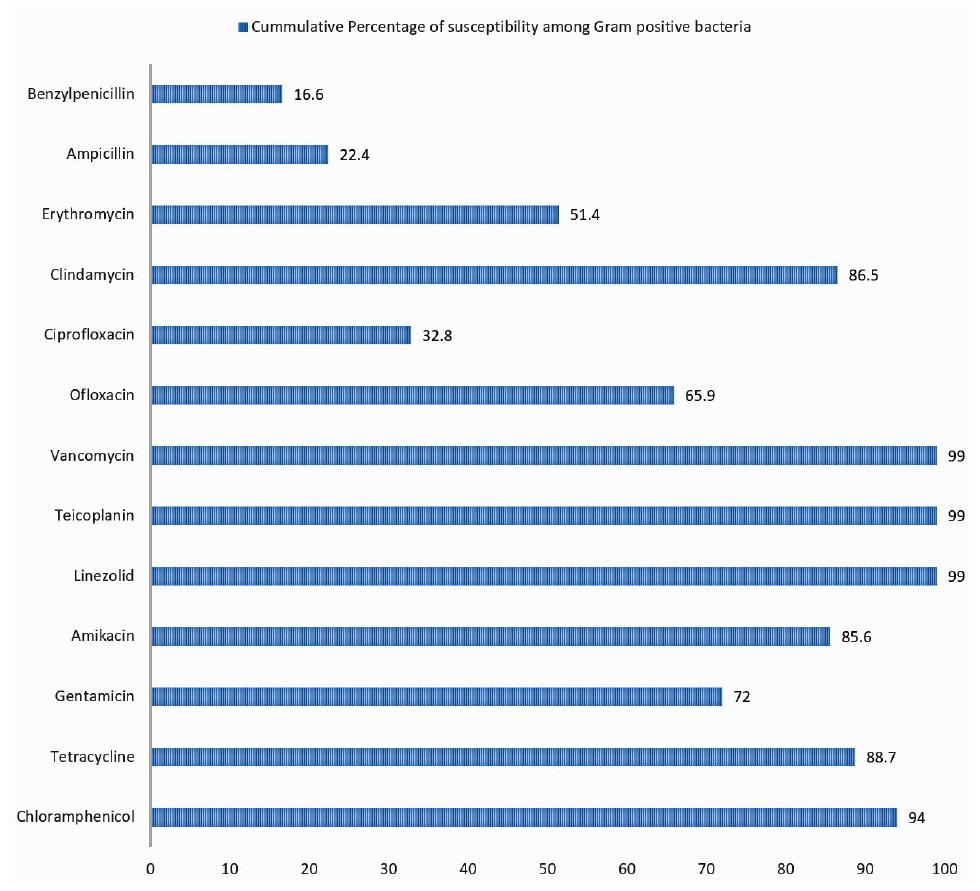
Fig. 4. Cumulative percentage of susceptibility of Gram-positive bacteria causing SSTI to individual antibiotics